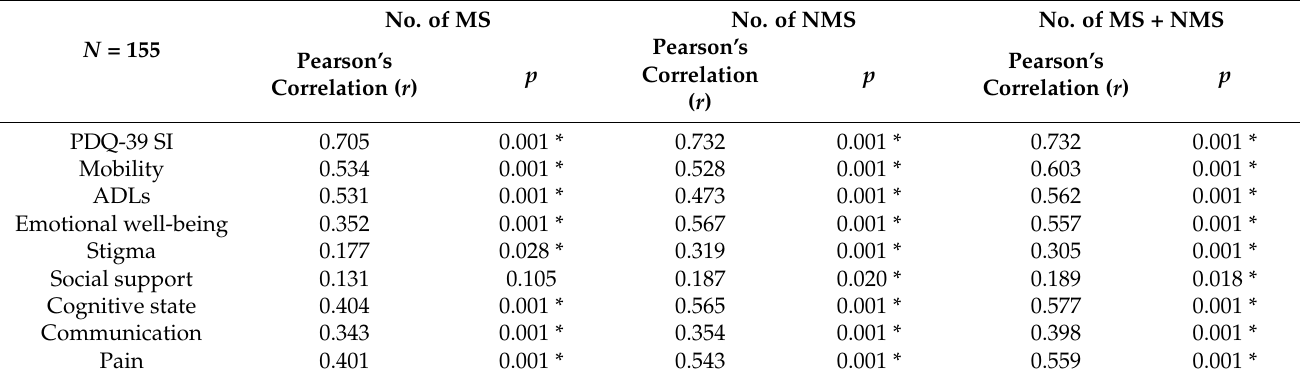
Table 3. Analysis of the relationship between the number of symptoms with the PDQ-39 SI and total PDQ-39 in each